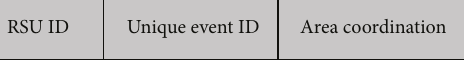
Figure 13: Advisory speed limit message